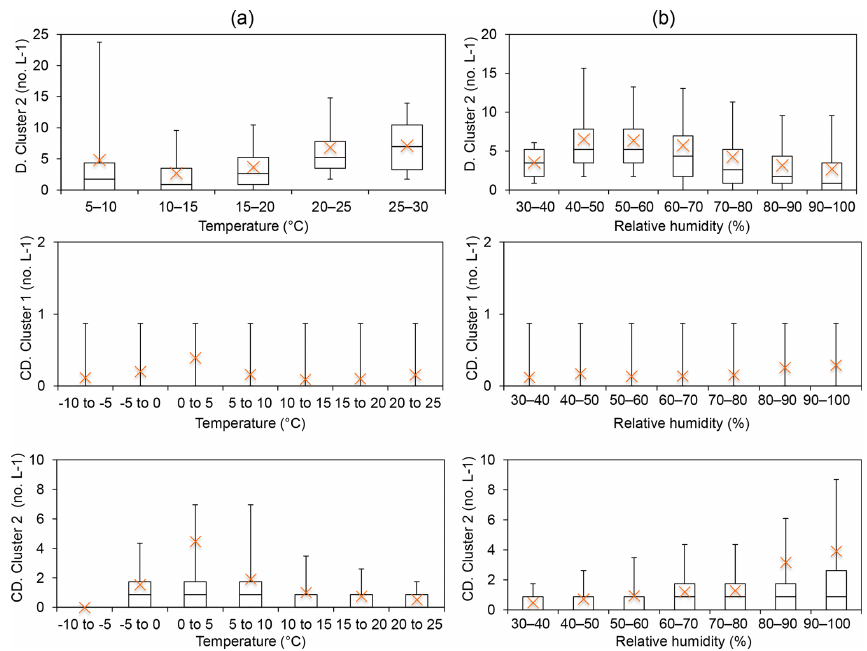
Figure 4. Group 6 was considered to be non-biological interferent particles following the HAC analysis, following Hernandez et al. (2016) in which FL2 (or type B) was the dominant signal. Instead, Davidstow Cluster 2 was deemed to be a bacterial particle, and Capel Dewi Cluster 1 and Cluster 2 wet discharged fungal spores following temperature (a) and relative humidity (b) analysis. (Site names shortened for brevity D – Davidstow, CD – Capel Dewi).